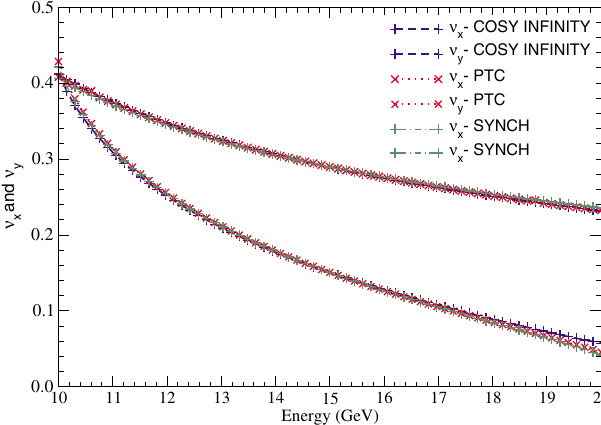
and (cid:22) calculated for the x y